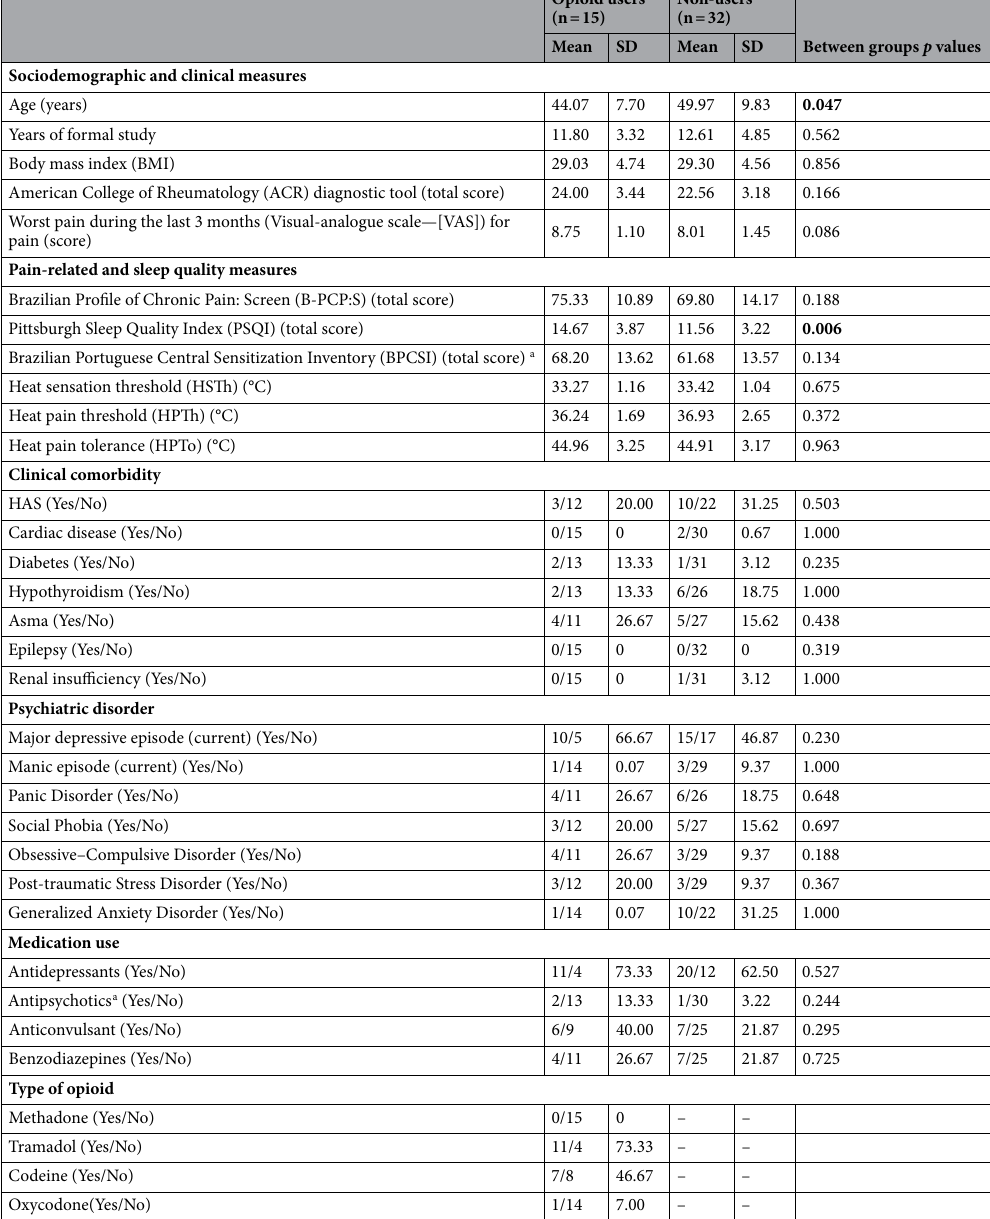
Table 1. Demographic and clinical characteristics of the study sample. Values are given as the mean (SD) or frequency (n = 47). Bold values indicates statistically significant differences (P < 0.05). P-values for continuous variables (Sociodemographic, clinical measures and Pain-related and sleep quality measures) are based on Independent Student t- tests. Categorical variables (clinical comorbidity, medication use and type of opioid) are based on Fisher’s exact test. a = Measures from one non-user were not obtained, therefore n =